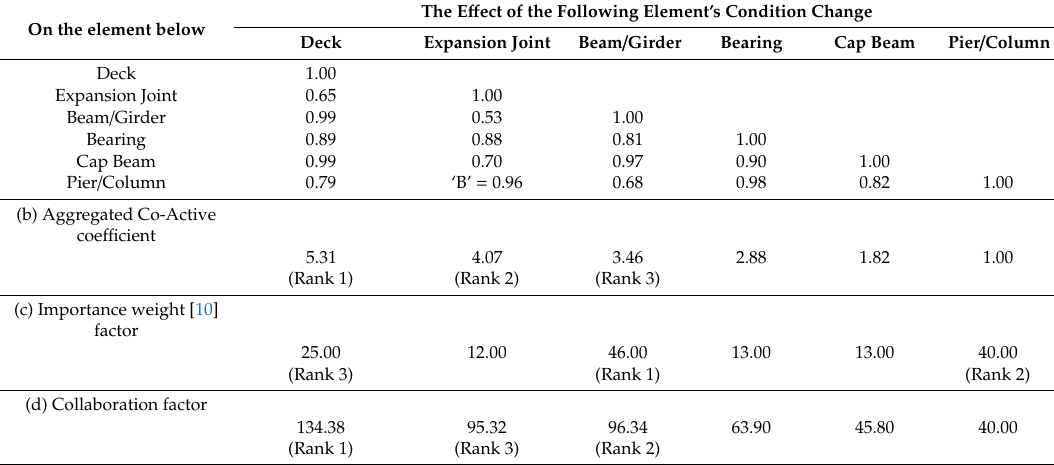
Table 6. Co-Active prioritization parameters in the ‘PC109’